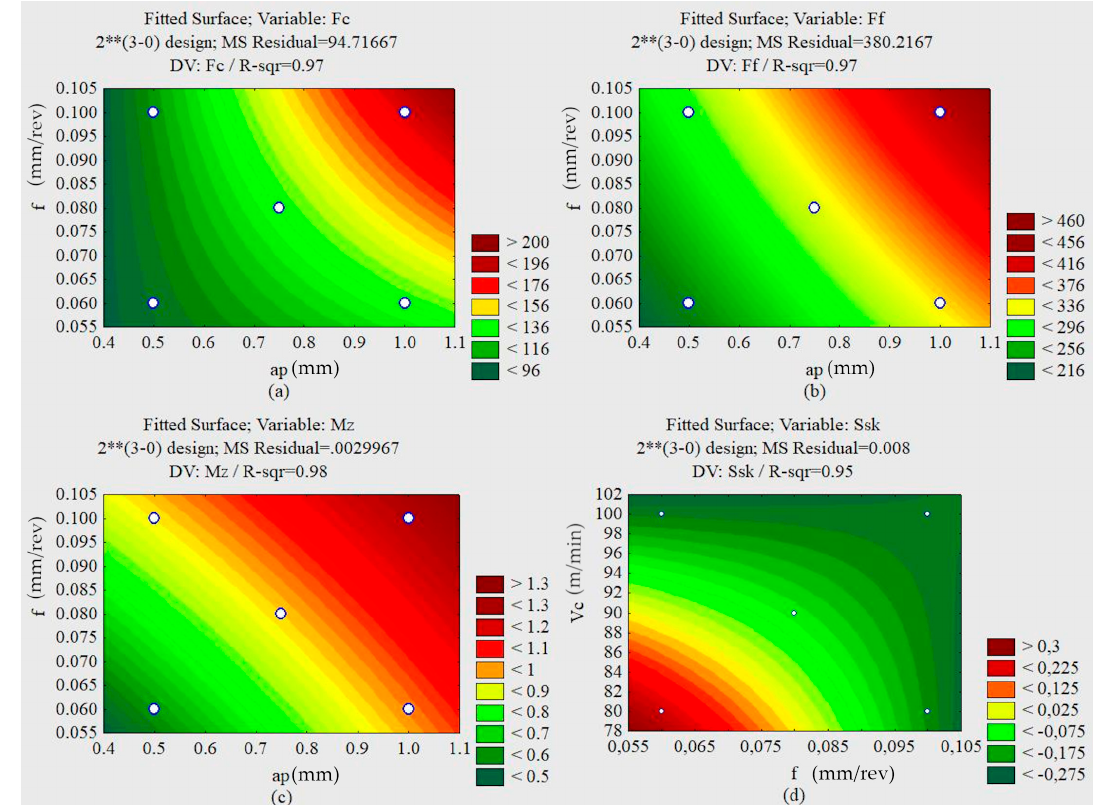
Figure 15. Response surfaces for the oil lubricated condition. ( a ) Cutting force F c (a p × f). ( b ) Feed force F f (a p × f). ( c ) Torque M z (a p × f). ( d ) Skewness (f × v c ).